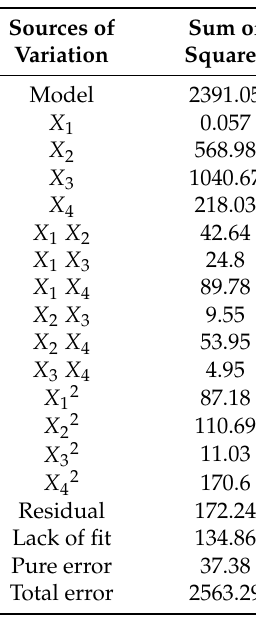
Table 2. Analysis of variance q.